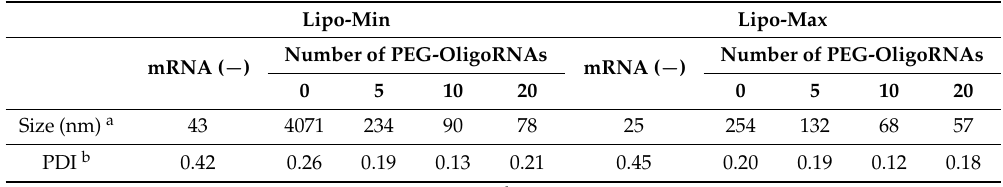
Table 2. Dynamic light scattering measurement of Lipofectamine LTX/mRNA lipoplexes.